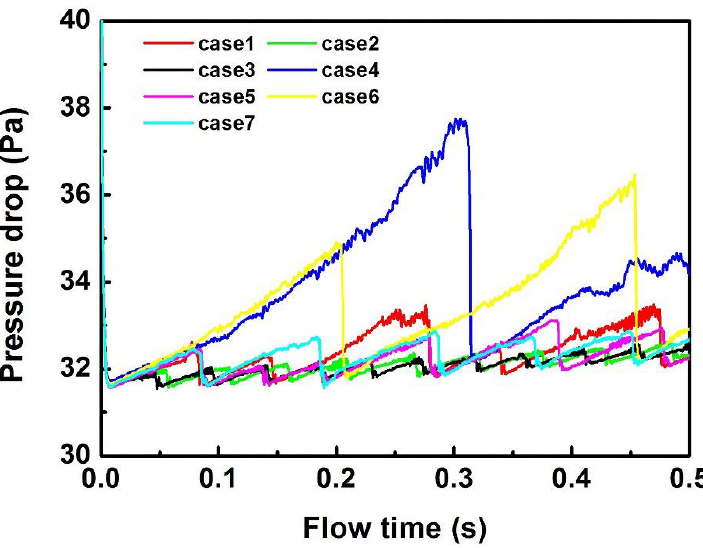
Figure 7. Effect of the pore shape on the pressure drop between the inlet and outlet of the channel.